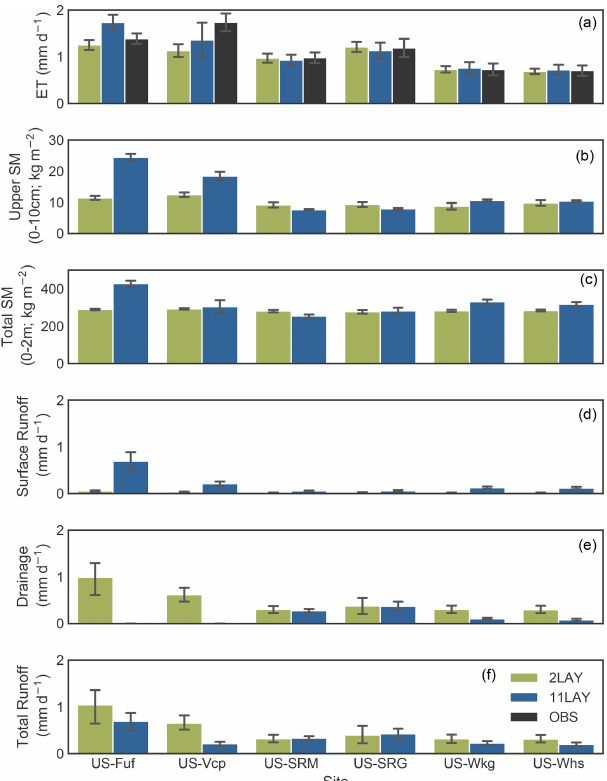
Figure 1. Comparison of the 2LAY vs. 11LAY mean daily